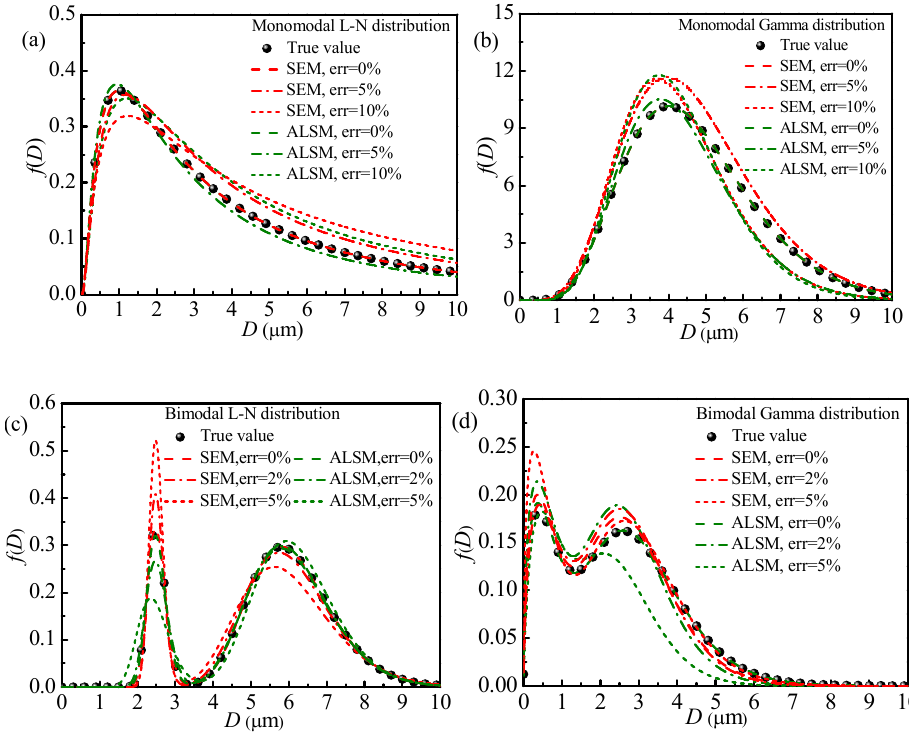
Figure 5. Reproducibility of different ASDs by using different optical measurement methods: ( a ) monomodal L-N distribution ; ( b ) monomodal Gamma distribution; ( c ) bimodal L-N distribution; ( d ) bimodal Gamma distribution.